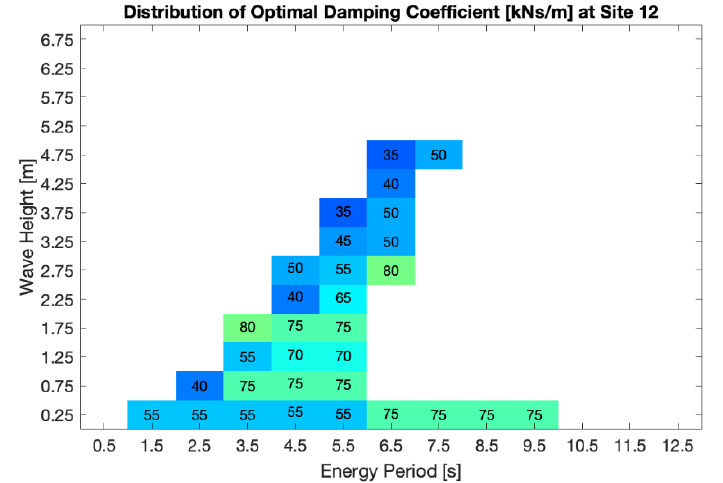
Figure 12. Scatter diagram displaying the distribution of optimal damping coefficients corresponding to the sea state from Site 12.